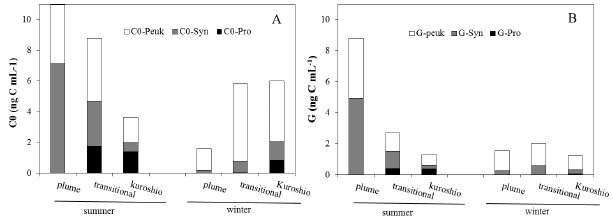
Fig. 9. Seasonal and regional composition of (A) picophytoplankton carbon biomass ( C 0 ) and (B) their contribution to microzooplank- ton carbon consumption ( G